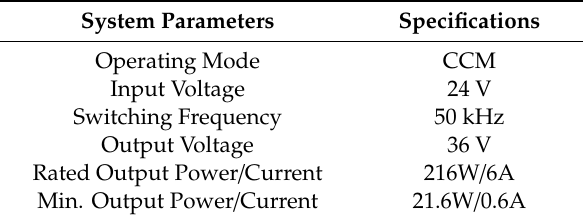
Table 1. System Specifications (CCM: continuous current mode)